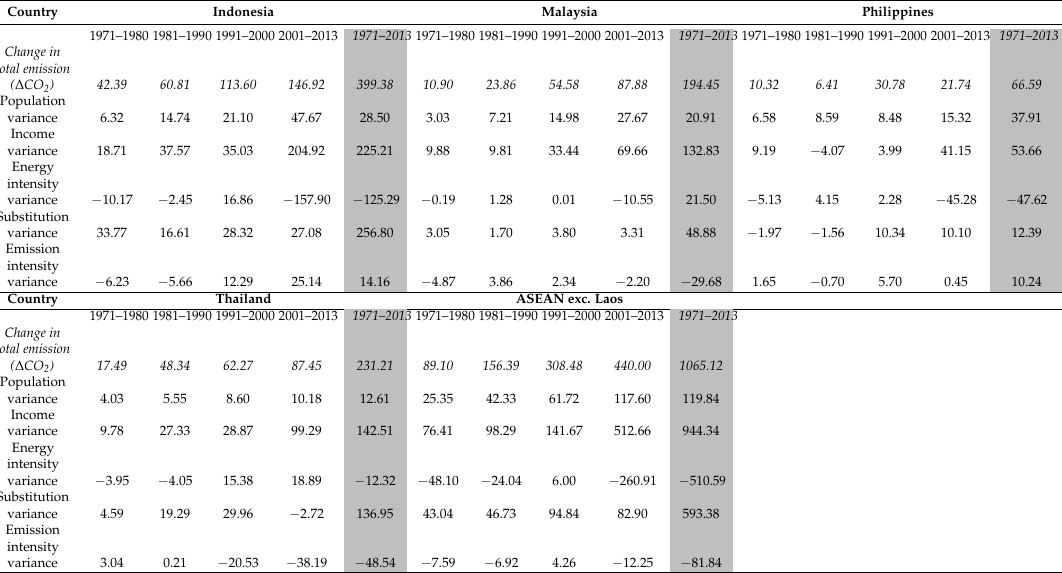
Table A1. Decomposition results of total CO 2 emissions in ASEAN and selected countries (Mt CO 2 ). Country